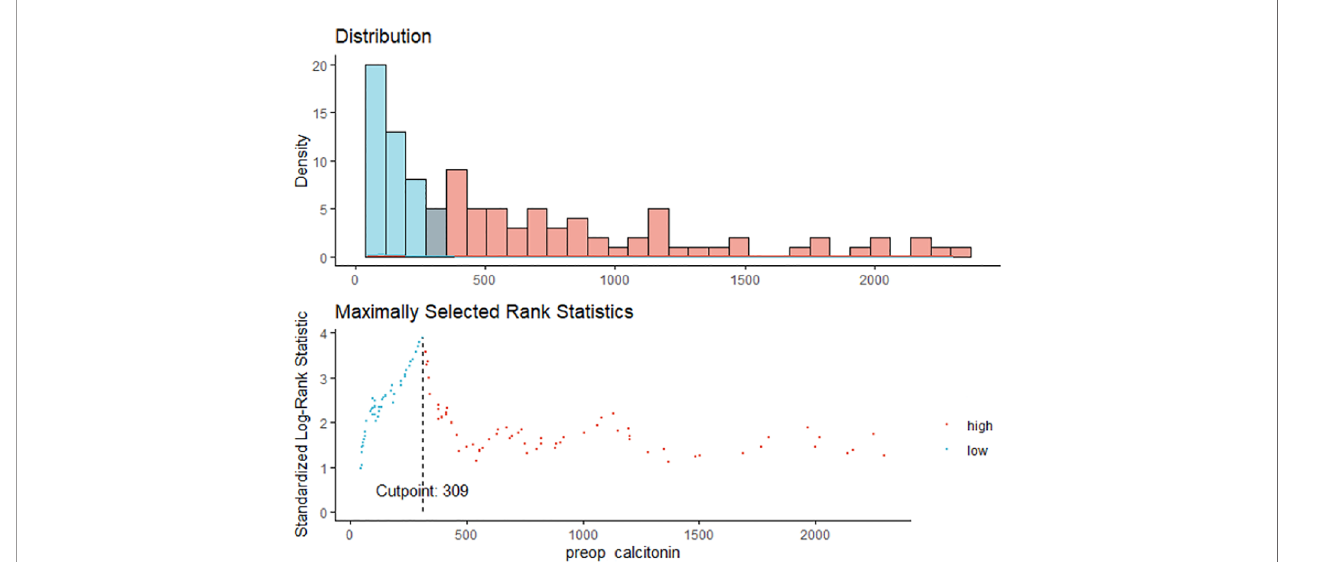
FIGURE 1 | The maximum of the standardized log-rank statistics for preoperative serum calcitonin cut-off value.